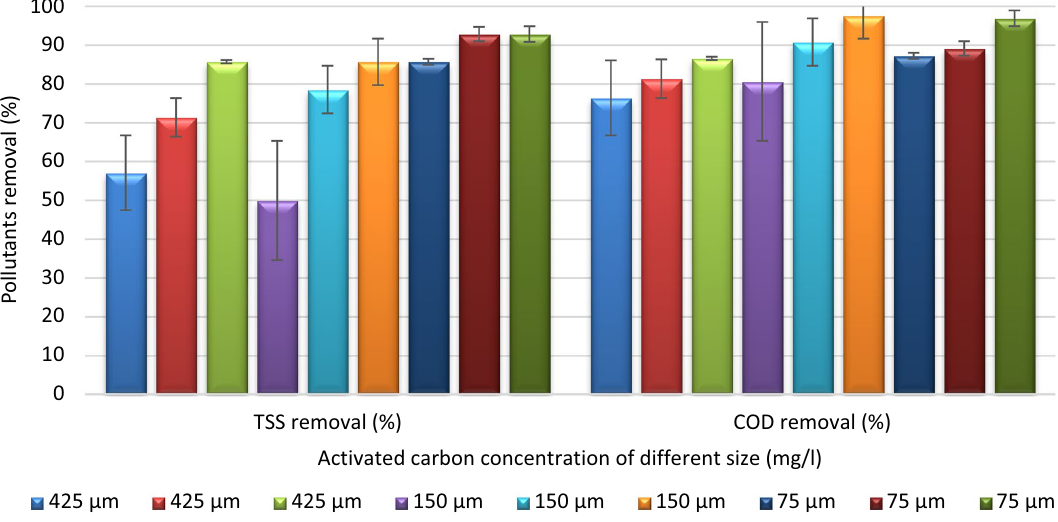
Fig. 7 Effect of coconut shell activated carbon concentration and size on removal efficiency of different